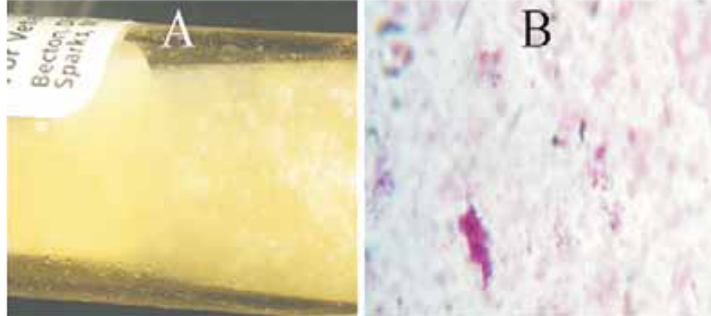
Figure-3: A Colonies morphology and microscopic appearance of culture positive pooled fecal samples. : Smooth colonies of MAP after 10 weeks of culture on a Herrold's egg yolk Medium containing mycobactin J (HEYM) in a sealed tube. : Microscopic appearance of MAP showing the red acid alcohol-fast ZN staining typical of mycobacterium in bacillary form.